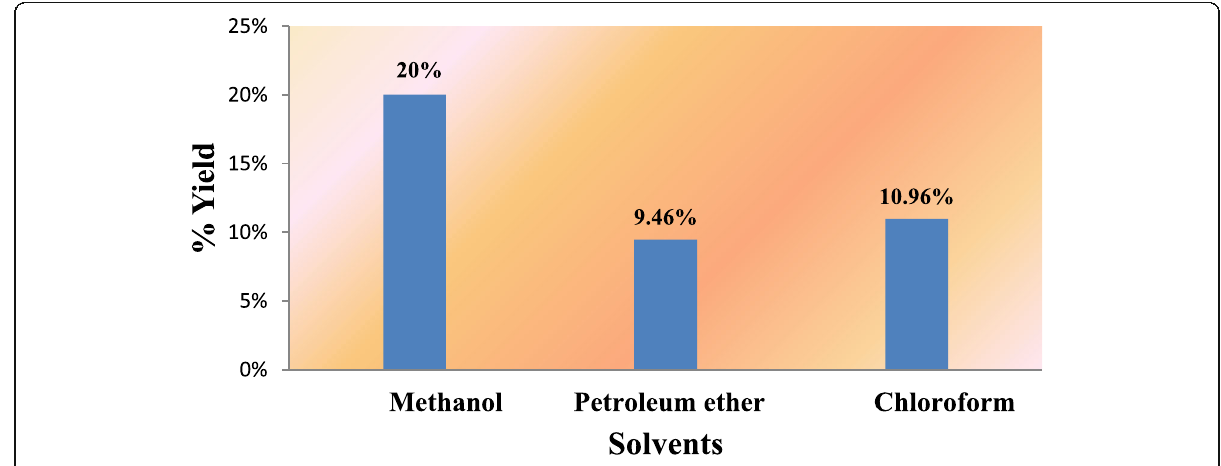
Fig. 2 Extractive yield (%) of Praecitrullus fistulosus